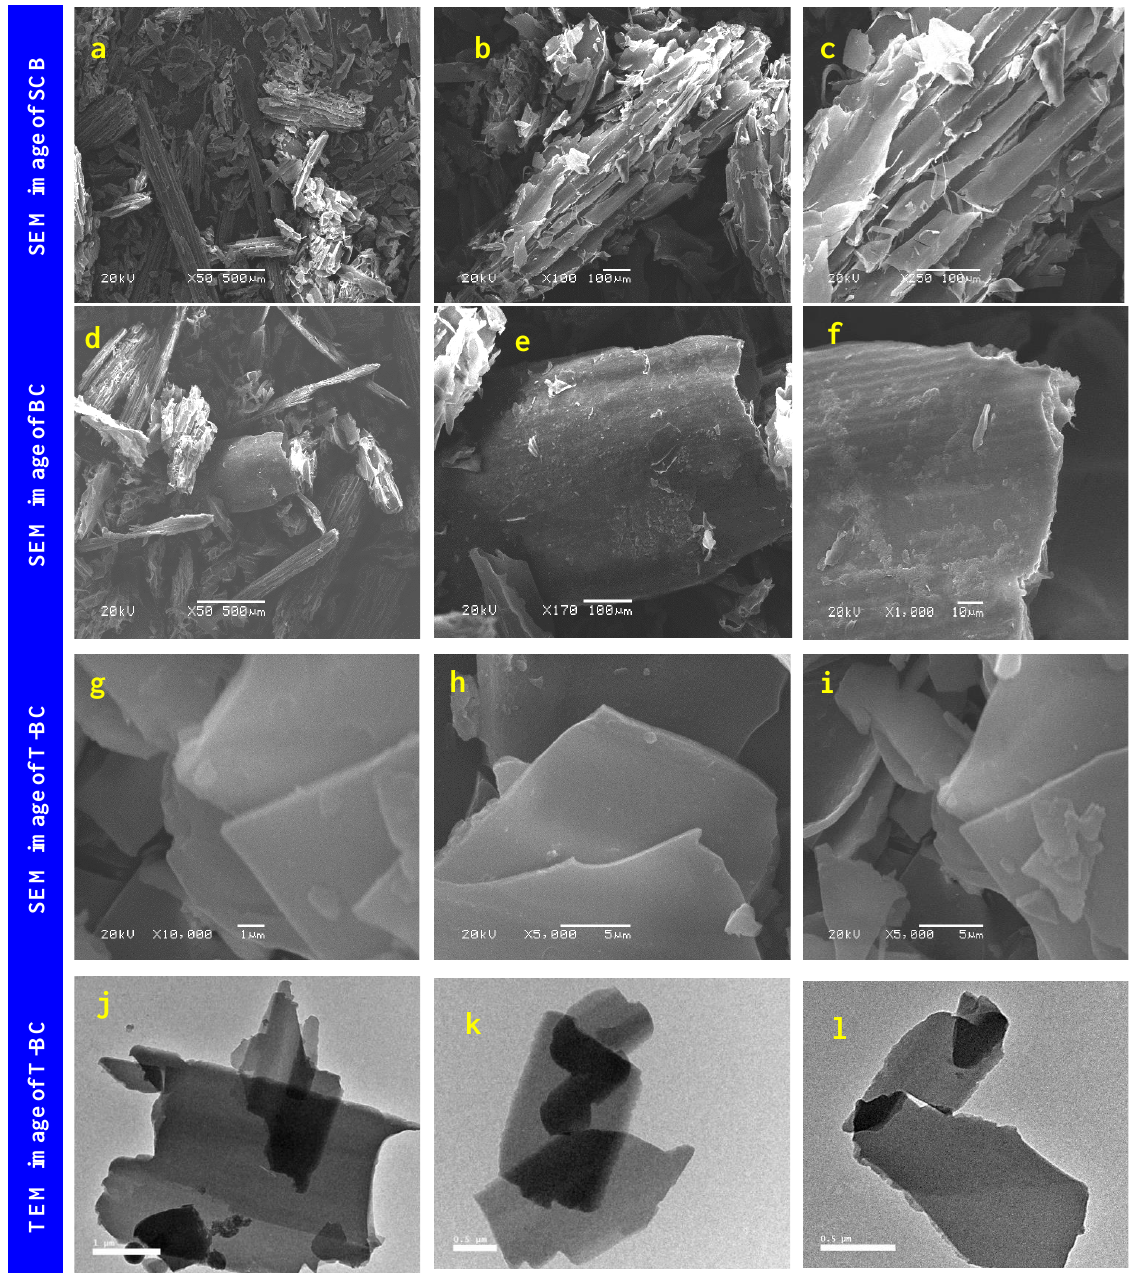
Figure 1. SEM image of SCB (a-c), BC (d-f), T-BC (g-i) and TEM image of T-BC (j-l).